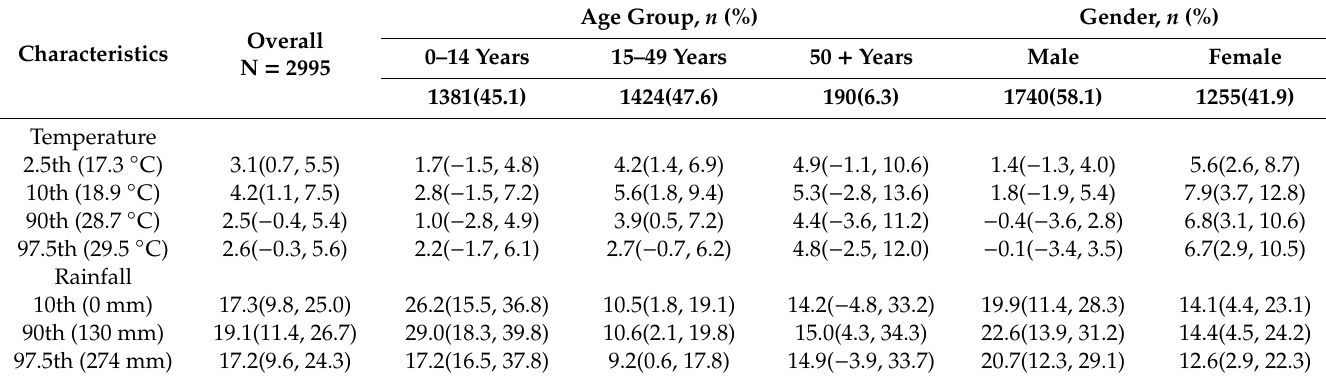
Table 2. Overall cumulative association (logarithms of relative risks (logRR) † , 95% CI) for malaria-temperature / rainfall distributed lag non-linear models (DLNM) for temperature percentiles and by sex and